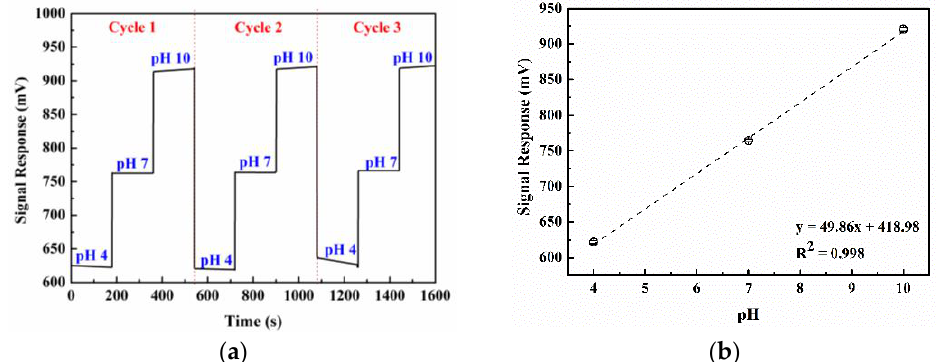
Figure 8. The pH sensitivity of ISFET sensor: ( a ) ISFET signal response given pH of 4, 7, and 10, ( b ) signal response relative to pH (mV).